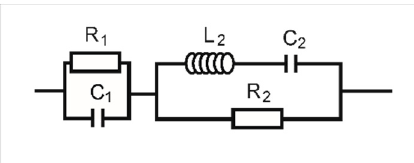
Figure 12. Equivalent electric circuit for the impedance response of GaSe(SmCl 3 ) (Figure 10b, black curve) measured in low-frequency region.